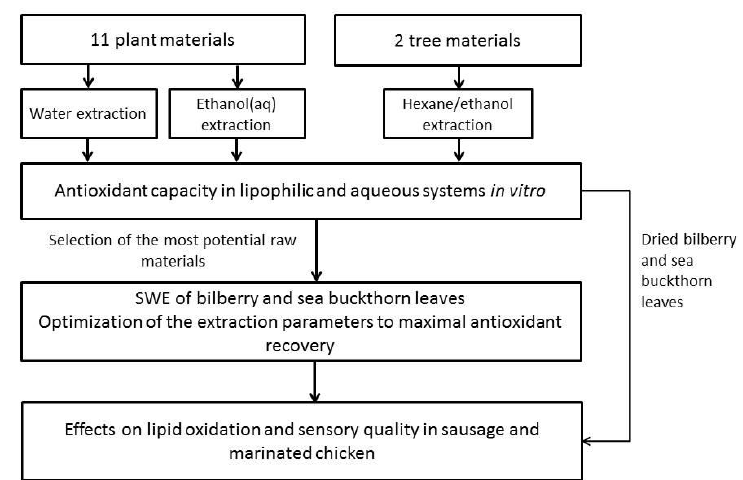
Figure 1. The flow diagram of the study. Chemical-free methods (water and SWE) were preferred for the recovery of antioxidants.